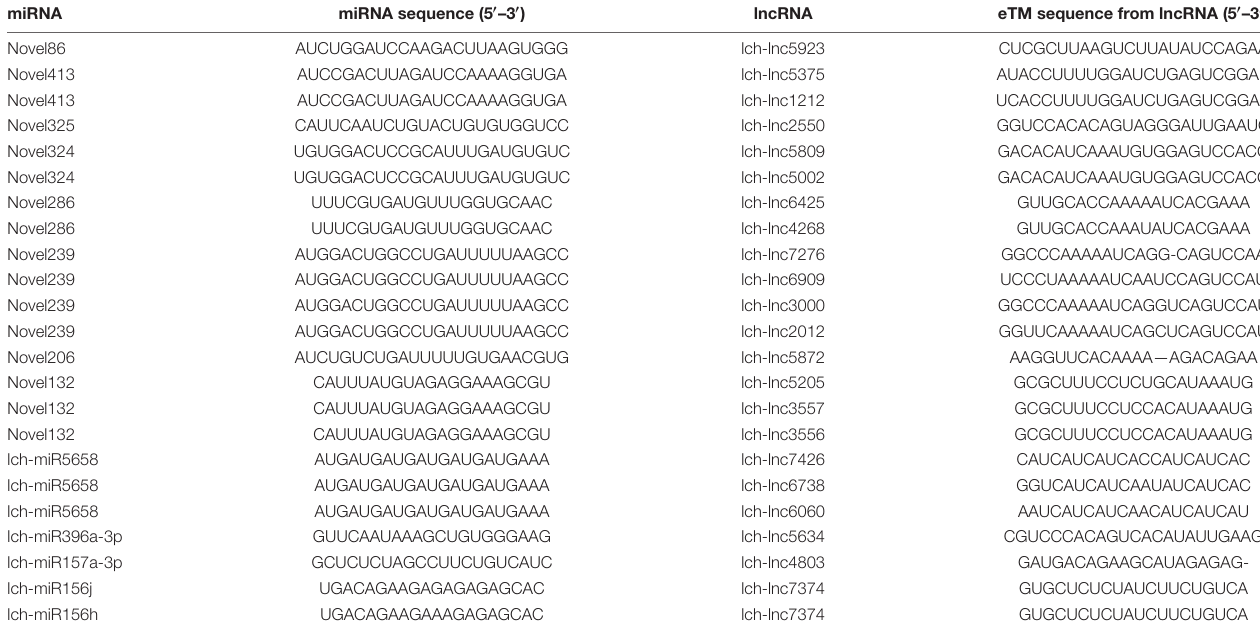
TABLE 1 | Information about eTMs of fourteen